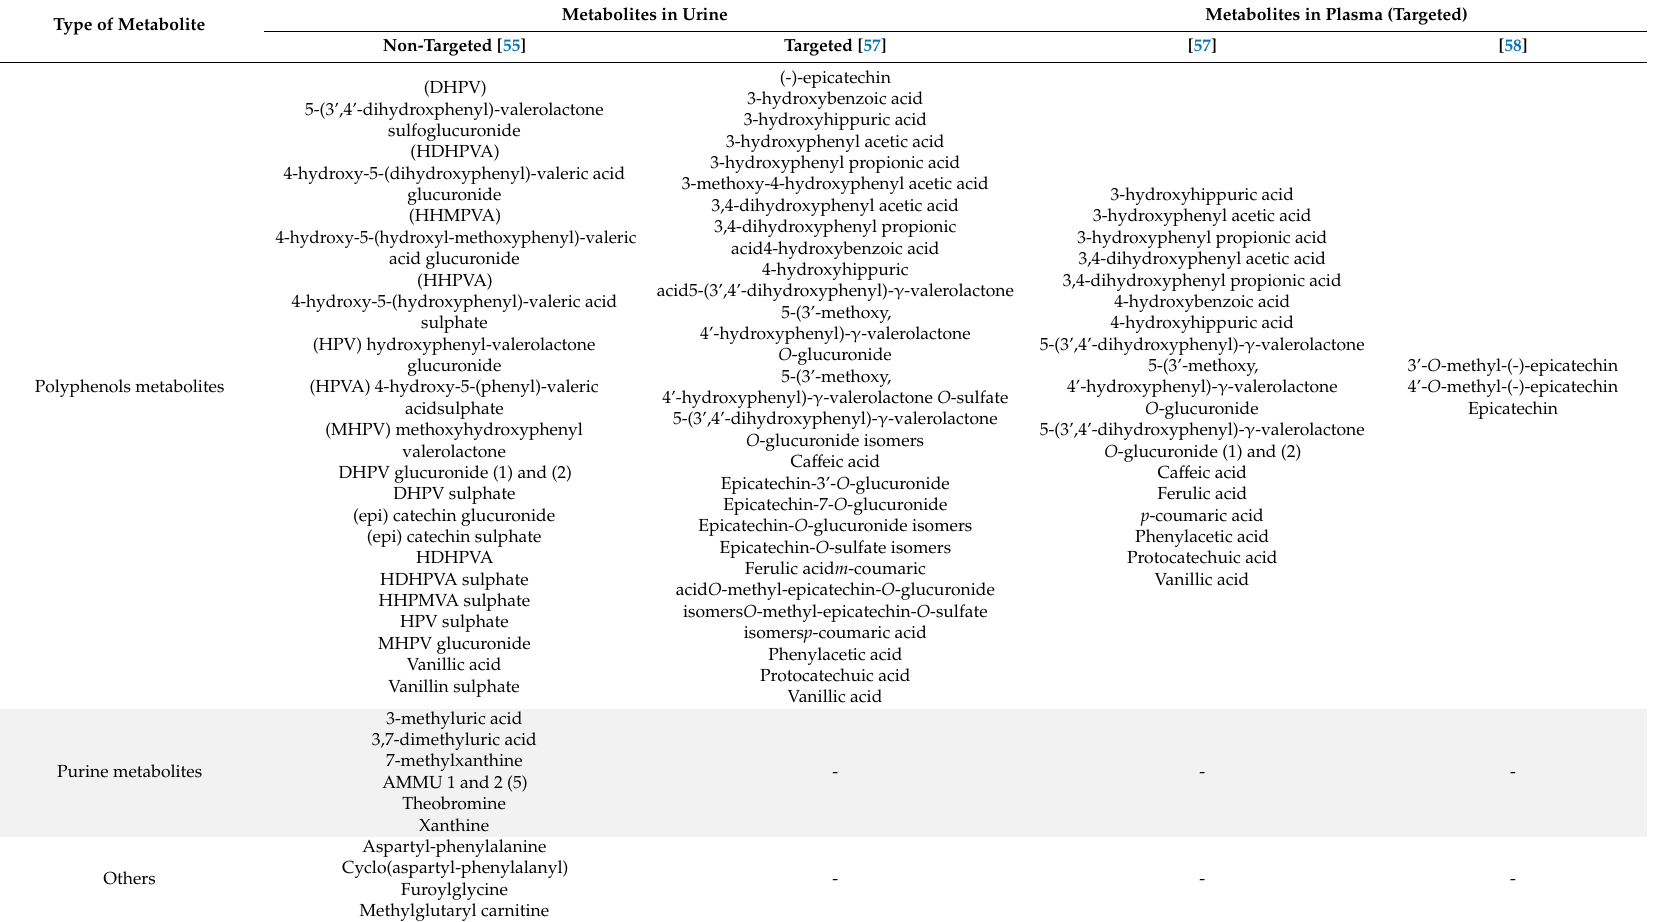
Table 8. Metabolites analyzed in urine and plasma after acute, short-term, or regular cocoa intake interventions, studied with non-targeted and targeted